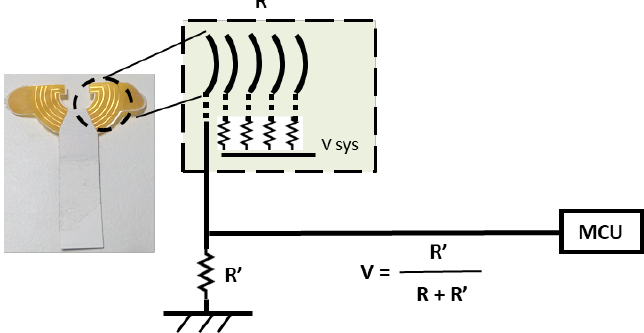
Figure 2. Circuit design of the sensor patch and the principle of cross-ring threshold.